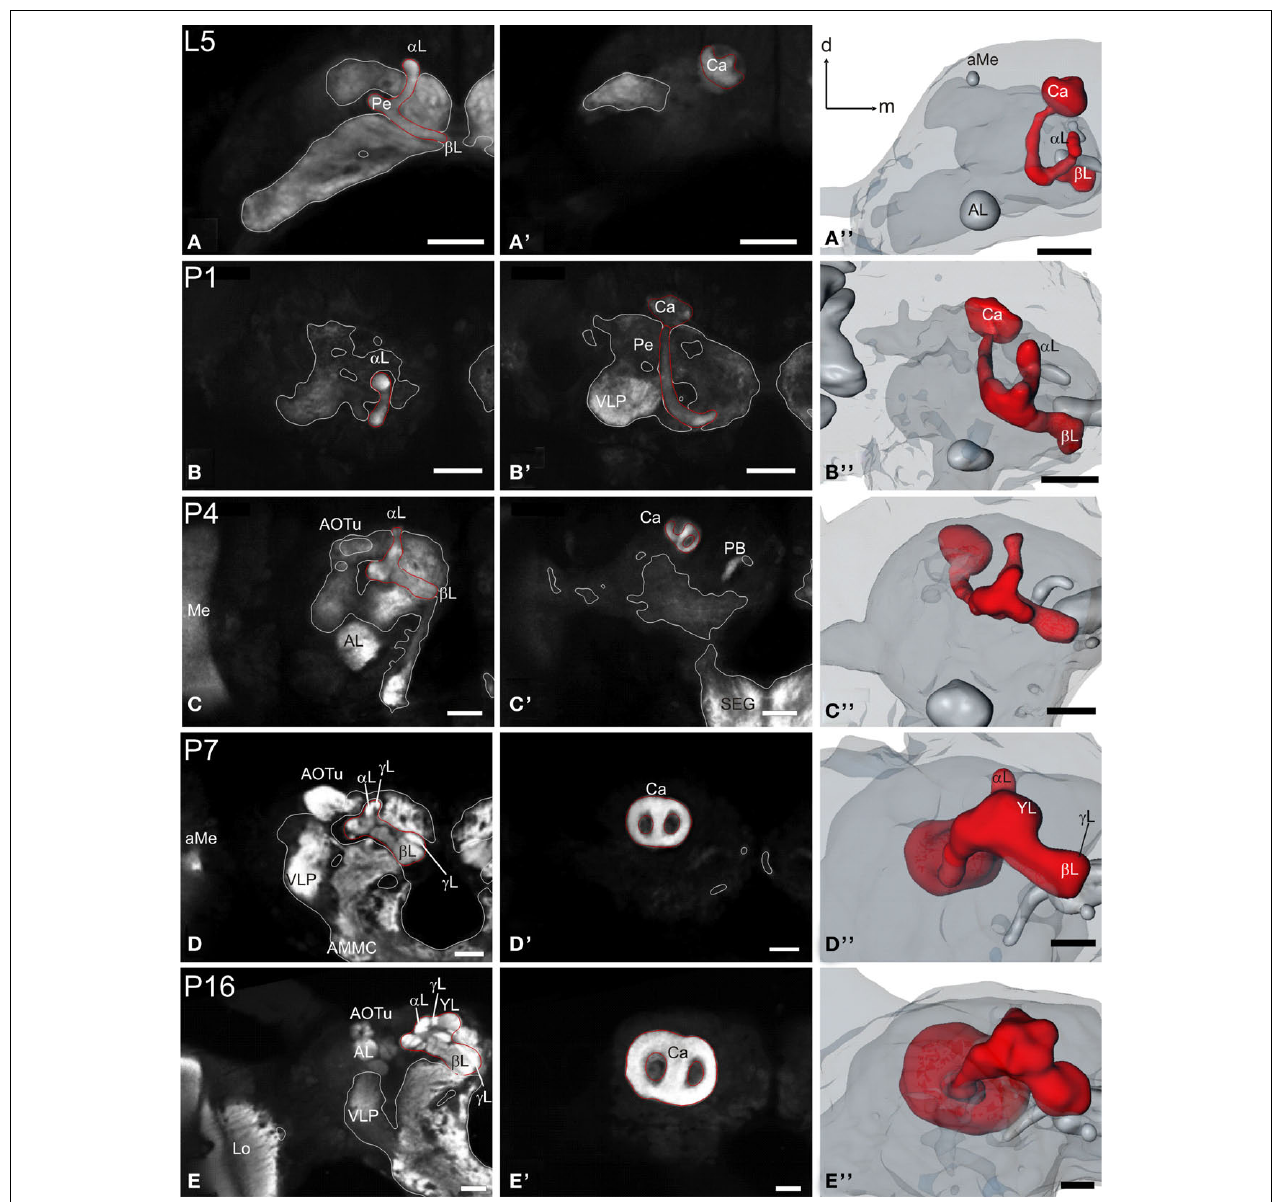
(P1): the peduncle shows a straightened orientation. (C–C ′′ ) Stage P4: the MB tilts from a ventro-dorsal orientation to a more antero-posterior orientation. (D–D ′′ ) Stage P7: the MB is oriented antero-posteriorly and has massively increased in size compared to stage P4. Additionally to the α L and β L, the γ -lobe ( γ L) and the Y-lobe (YL) appear as protrusions on the MB. (E–E ′′ ) Stage P16: the MB reached its fi nal adult orientation and shape. Orientation bars: d, dorsal; m, medial; all scale bars: 100